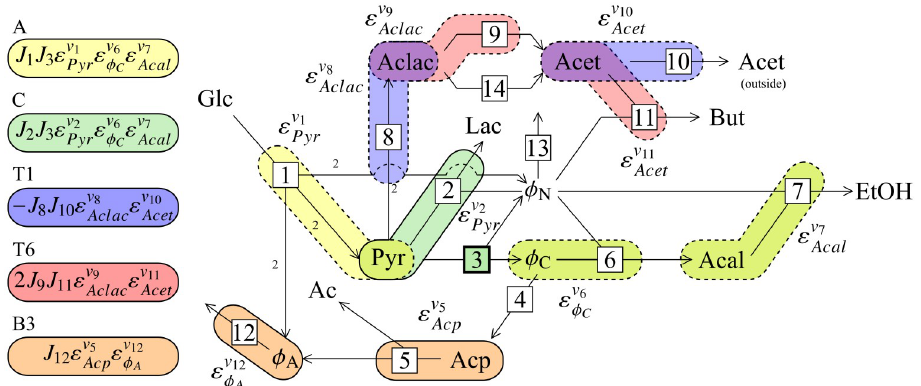
Fig 7. The components of control patterns 001 and 071 of C J 6 . Backbone and multiplier patterns that constitute the v 3 dominant control patterns of group 1 and group 4 (CP001 and CP071) are indicated as groups of coloured bubbles that highlight their elasticity coefficient components as indicated by the key. These control patterns have different backbone patterns (A and C), as well as different multipliers (T1 and T6).